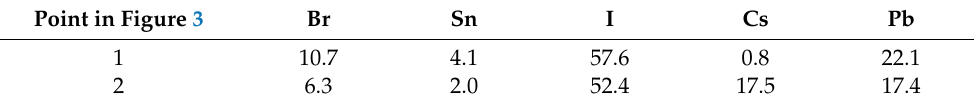
Table 1. Elemental composition of the 30% CsI containing perovskite film surface, atomic % (oxygen and titanium values not included).